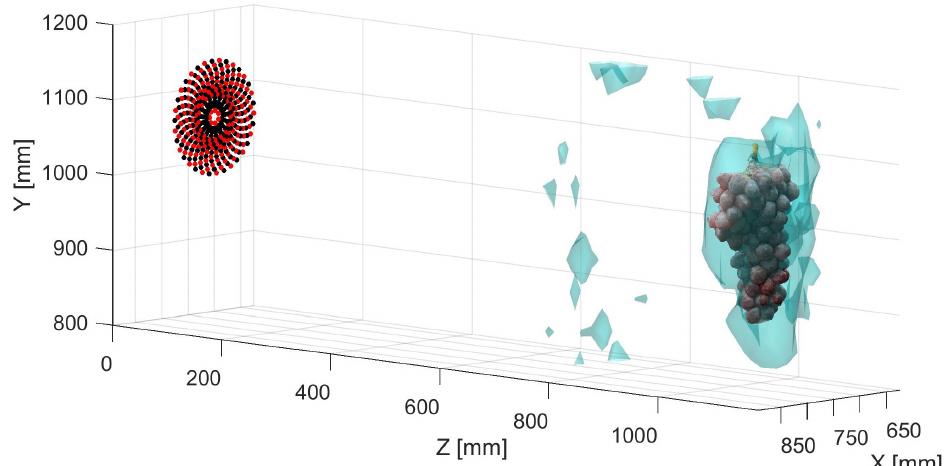
Figure 13. The isosurface plot was achieved using a fan to agitate the leaves and performing filtering of the signal using the average and variance for 20 recordings. When comparing this plot with Figure 12, one can see that this technique allowed one to mainly remove the echoes from the